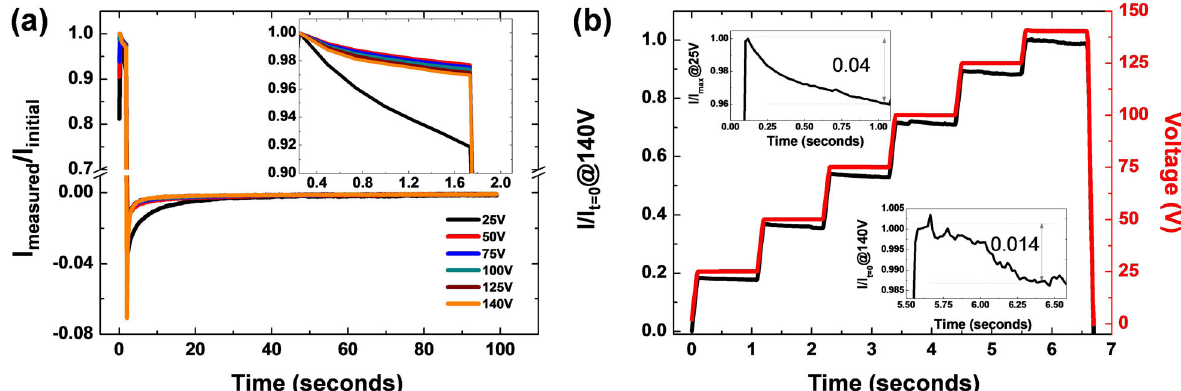
Fig. 11 Polarization measurements for Cs 2 AgIn 0.9 Bi 0.1 Cl 6 . a Pulse-voltage measurement: Voltage V applied for 2 s followed by 0 V for 100 s and current